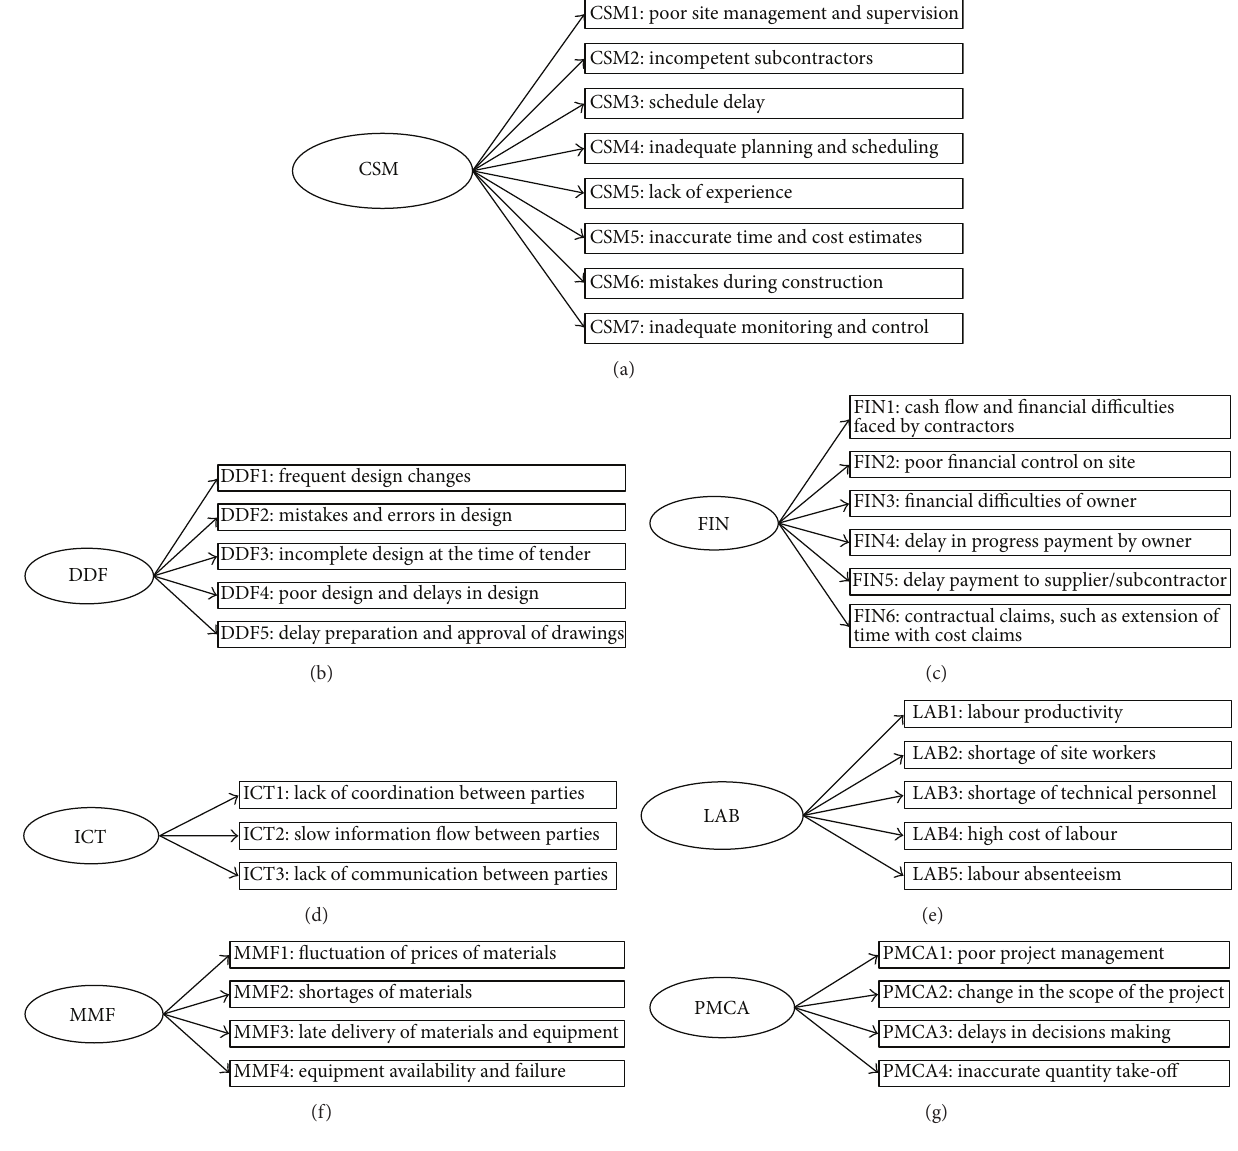
Figure 2: Path diagrams showing the descriptions of manifest